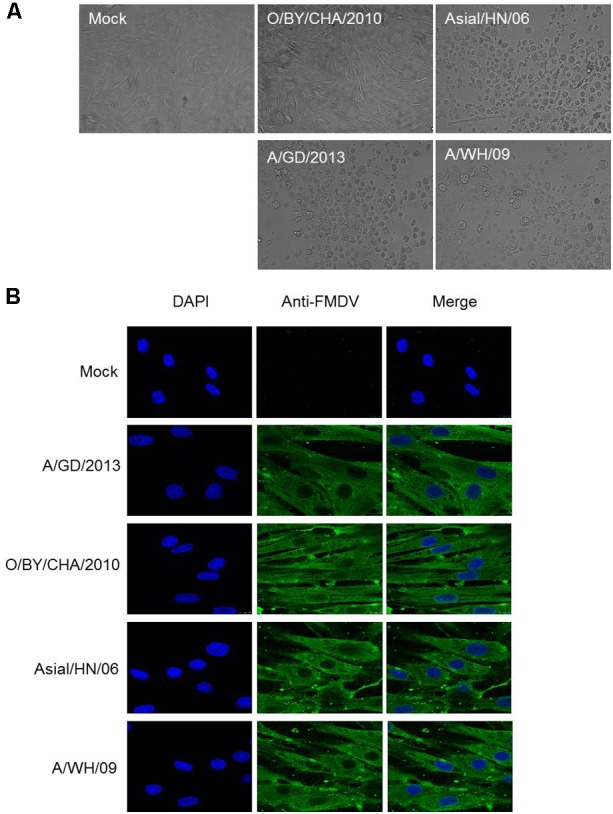
Growth characteristics of FMDV strains in hTERT-BTY cells. (A) CPE caused by O/BY/CHA/2010, Asial/HN/06, A/GD/2013, and A/WH/09 at MOI 0.001 on the passage-30 hTERT-BTY cell line at 72 hpi. (B) Immunofluorescence assay of hTERT-BTY cells infected with FMDV. hTERT-BTY cells (2 × 105 cells/well) were infected with or without O/BY/CHA/2010, Asial/HN/06, A/GD/2013, and A/WH/09 at a MOI of 0.001. The distribution of FMDV (green) was observed using confocal microscopy 24 h after the infection. hpi, hours post infection.